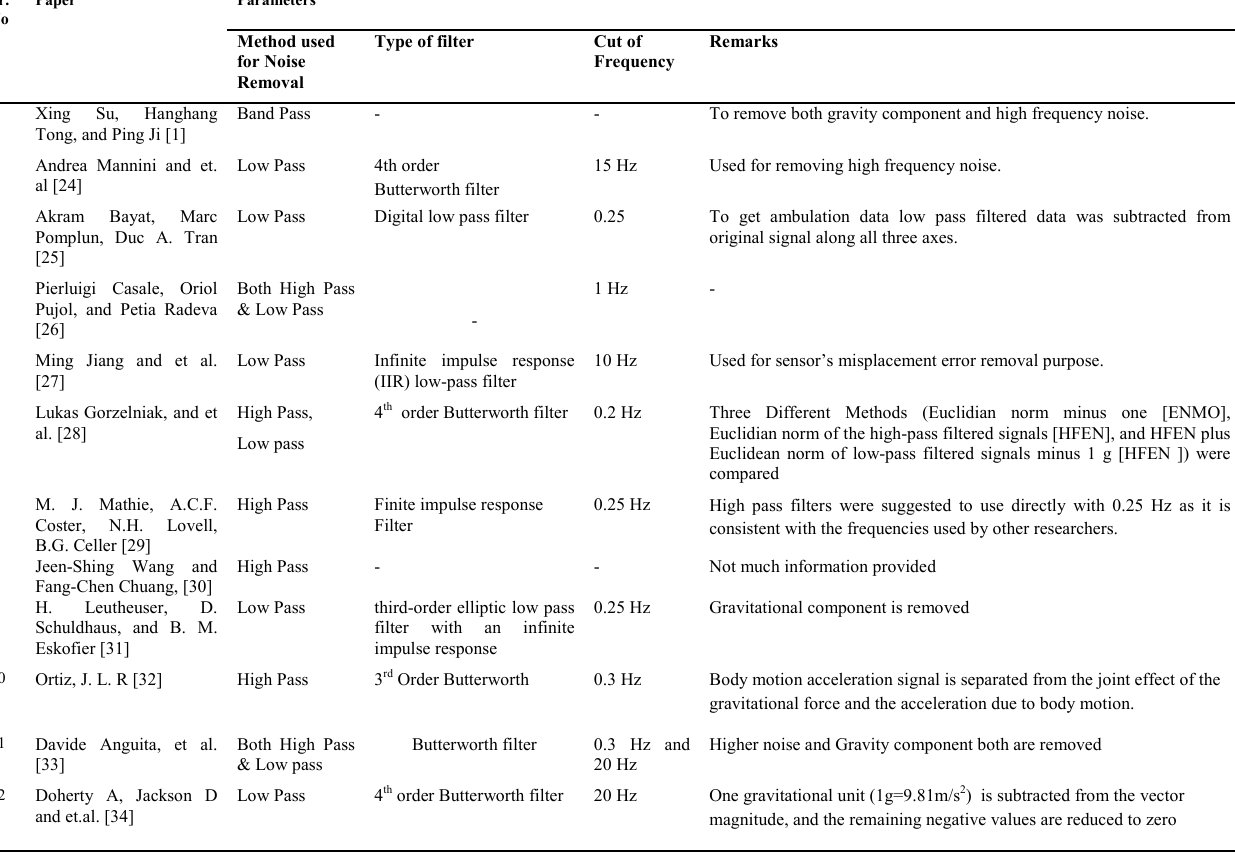
Table 1. Comparison of Filters Used for Noise